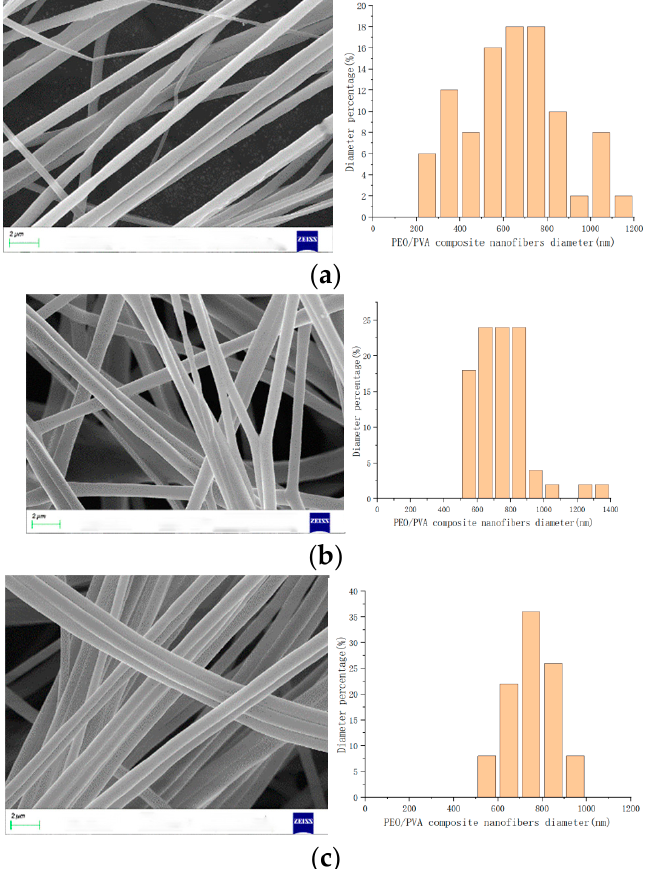
Figure 9. PEO/PVA composite nanofibers with different speeds. ( a ) 1500 rpm; ( b ) 2100 rpm; ( c ) 2700